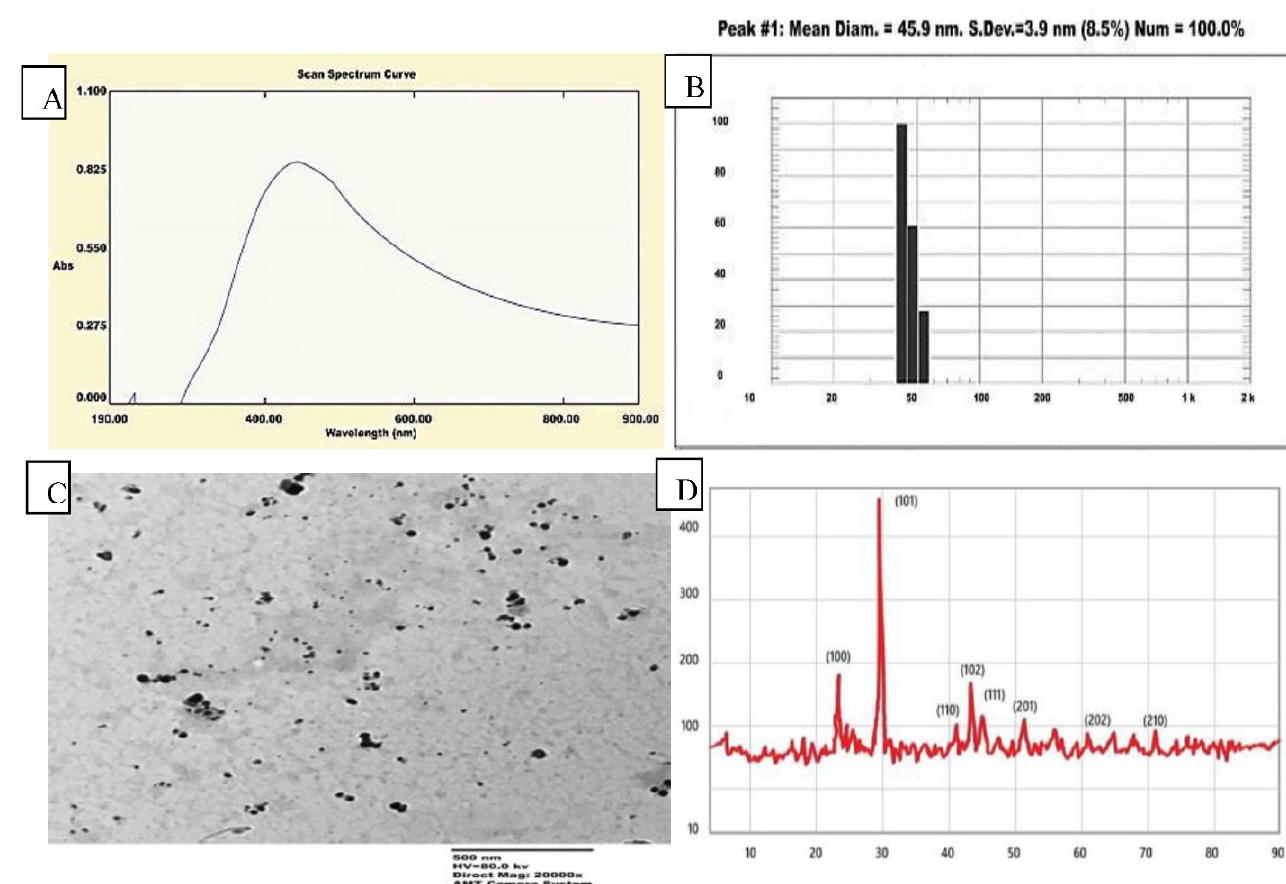
Figure 1. Characterization of bacteriogenic Se-NPs produced by B. megaterium ( A – D ); ( A ) UV-Visible spectrum; ( B ) dynamic light scattering (DLS); ( C ) TEM image; ( D ) XRD.